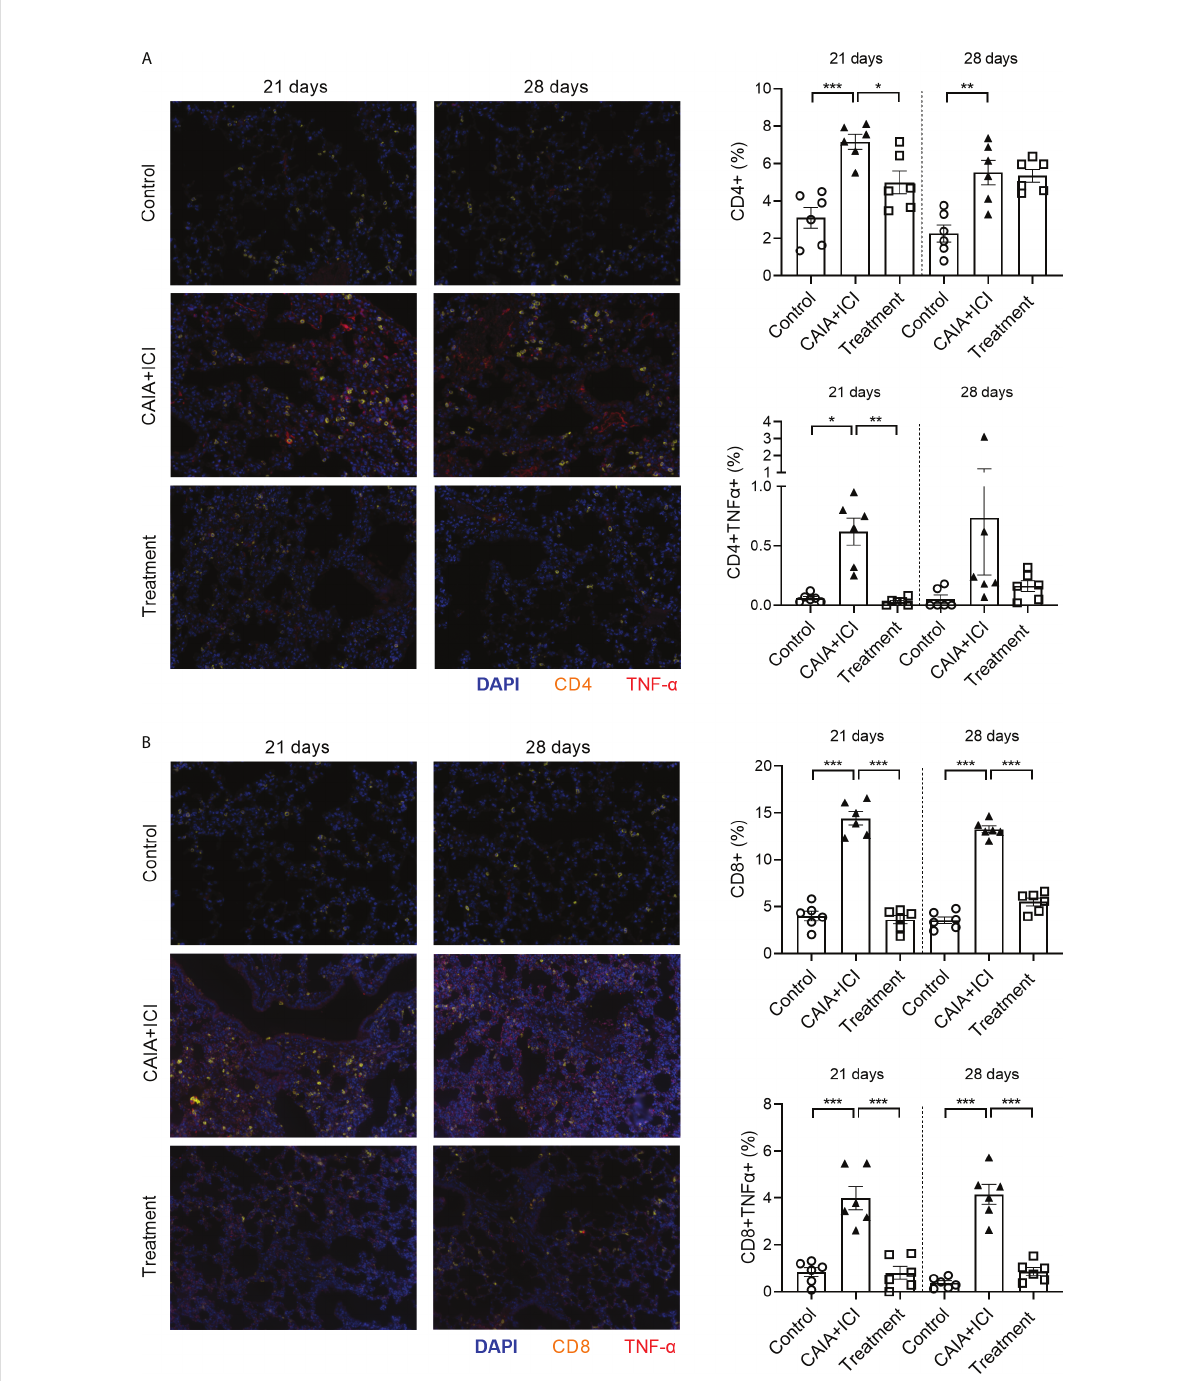
FIGURE 6 Anti-TNF- a treatment reduces TNF- a secreting T cell in fi ltrates in the lung of mice. The lung tissue sections from the indicated groups of mice on day 21 or 28 post induction were stained with fl uorescent anti-mouse CD4 or anti-mouse CD8, anti-TNF- a and nuclear-stained with DAPI. The lung tissue sections were scanned by Vectra Polaris. (A, B) Representative fl uorescent images of lung tissue sections and quantitative analysis of the frequency of CD4 + , TNF- a + CD4 + , CD8 + and TNF- a + CD8 + T cells in mice. Data are representative fl uorescent images of lung tissue sections or presented as means ± SEM of each group (n=6) of mice. Statistical signi fi cance was analyzed by one-way ANOVA and post hoc Bonferroni test. * p < 0.05, ** p < 0.01, *** p <